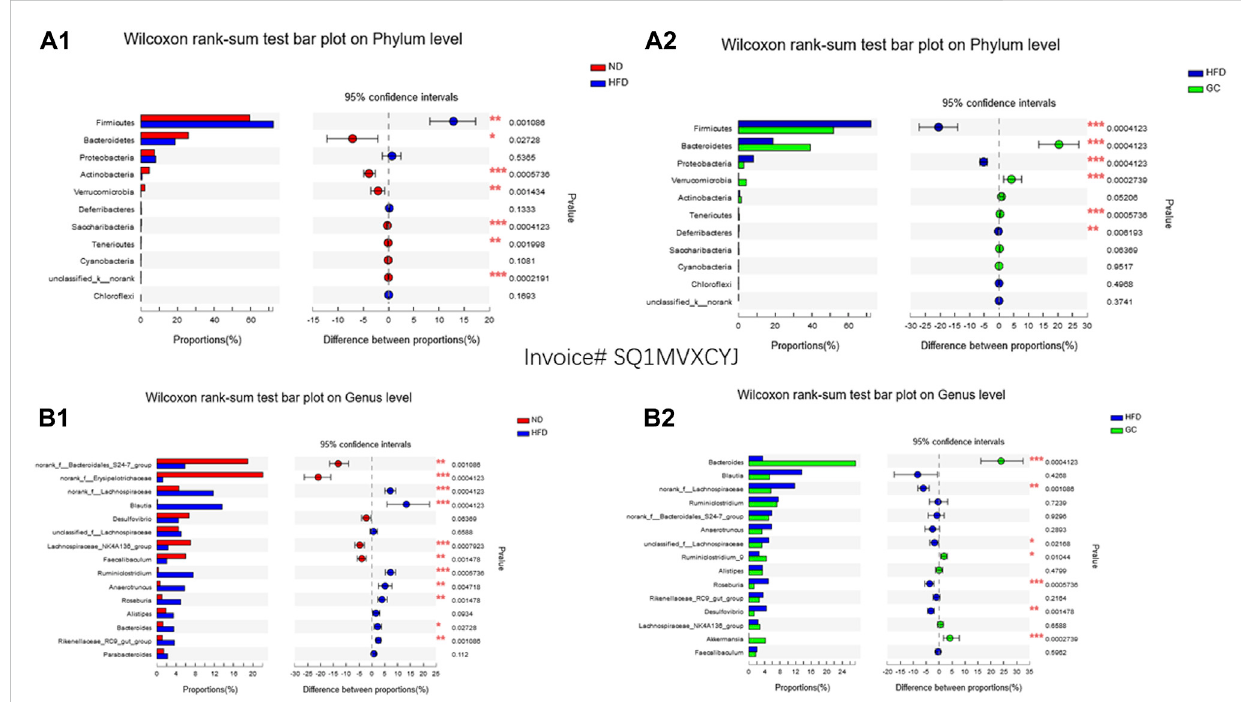
FIGURE 5 Changes in the gut microbiota and intervention with GC in a mouse NAFLD model. The gut microbiota data were analyzed by using the online Majorbio cloud platform (www.majorbio.com). (A1) Wilcoxon rank-sum test of changes at the phylum level. The data show the changes in the gut microbiota of mice in the HFD and ND groups at the phylum level. (A2) Wilcoxon rank-sum test of changes at the phylum level. The data show the changes in the gut microbiota of mice in the HFD + GC and HFD groups at the phylum level. (B1) Wilcoxon rank-sum test of changes at the genus level. The data show the changes in the gut microbiota of mice in the HFD and ND groups at the genus level. (B2) Wilcoxon rank-sum test of changes at thegenuslevel.ThedatashowthechangesinthegutmicrobiotaofmiceintheHFD+GCandHFDgroupsatthegenuslevel.Abbreviations:NAFLD,non- alcoholic fatty liver disease; ND, normal diet; HFD, high-fat diet; GC, HFD + geniposide and chlorogenic acid combination treatment. * p < 0.05, ** p < 0. 01, and *** p < 0.001 ( n = 9 per